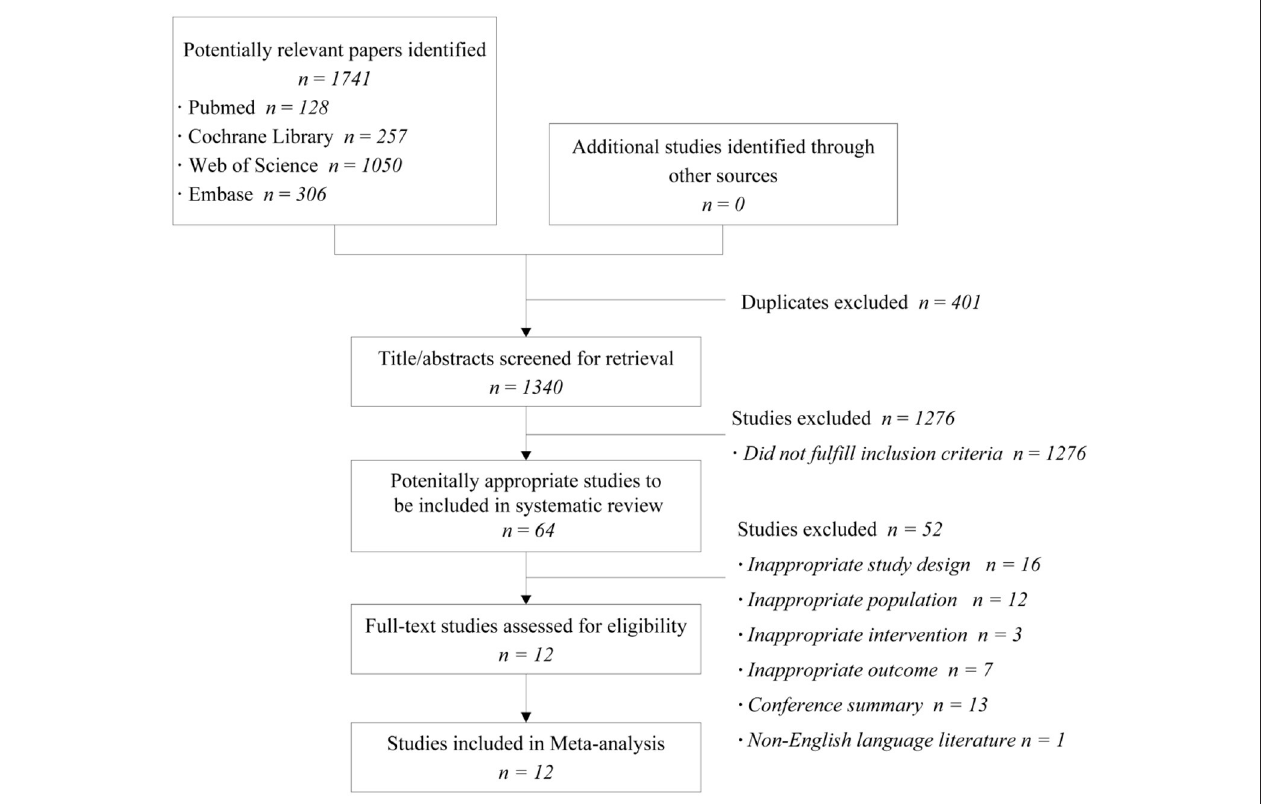
FIGURE 1 | Flow diagram of the study selection